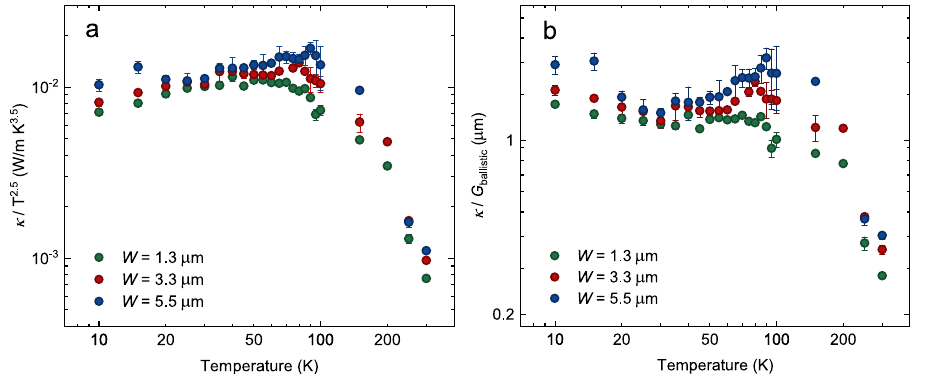
Fig. 3 | The criterion and evidence of phonon Poiseuille fl ow in isotopically puri fi ed graphite ribbons. a The usual criterion, namely the ratio of thermal conductivity( κ )overT 2.5 asafunctionof temperature(T)forgraphiteribbonswith various widths ( W ). b The present criterion, namely the ratio of thermal